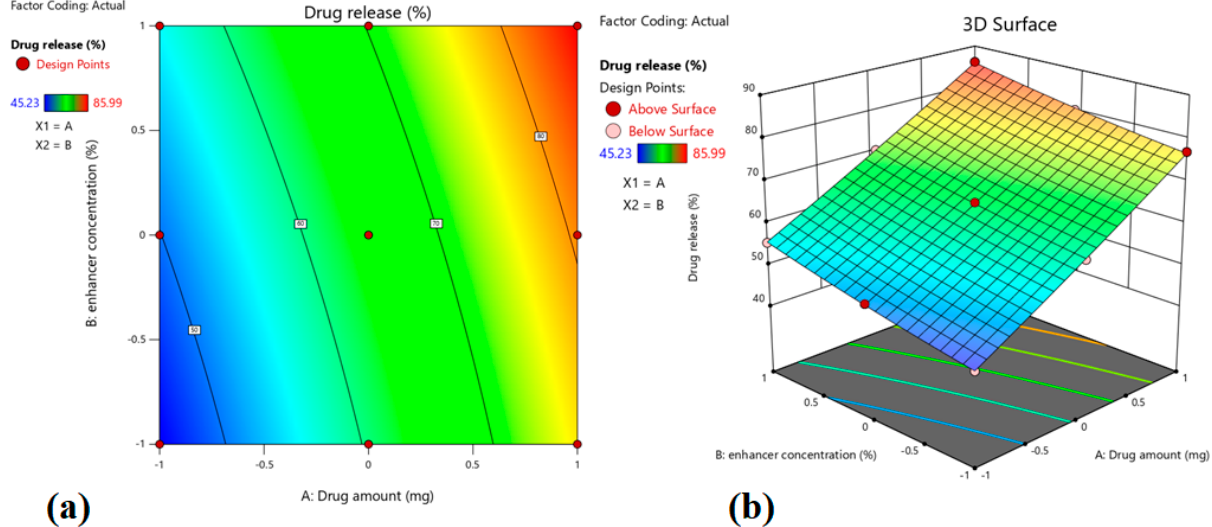
Figure 1. Contour plot ( a ) and 3D surface plot ( b ) show the effect of drug amount and enhancer concentration on drug release.